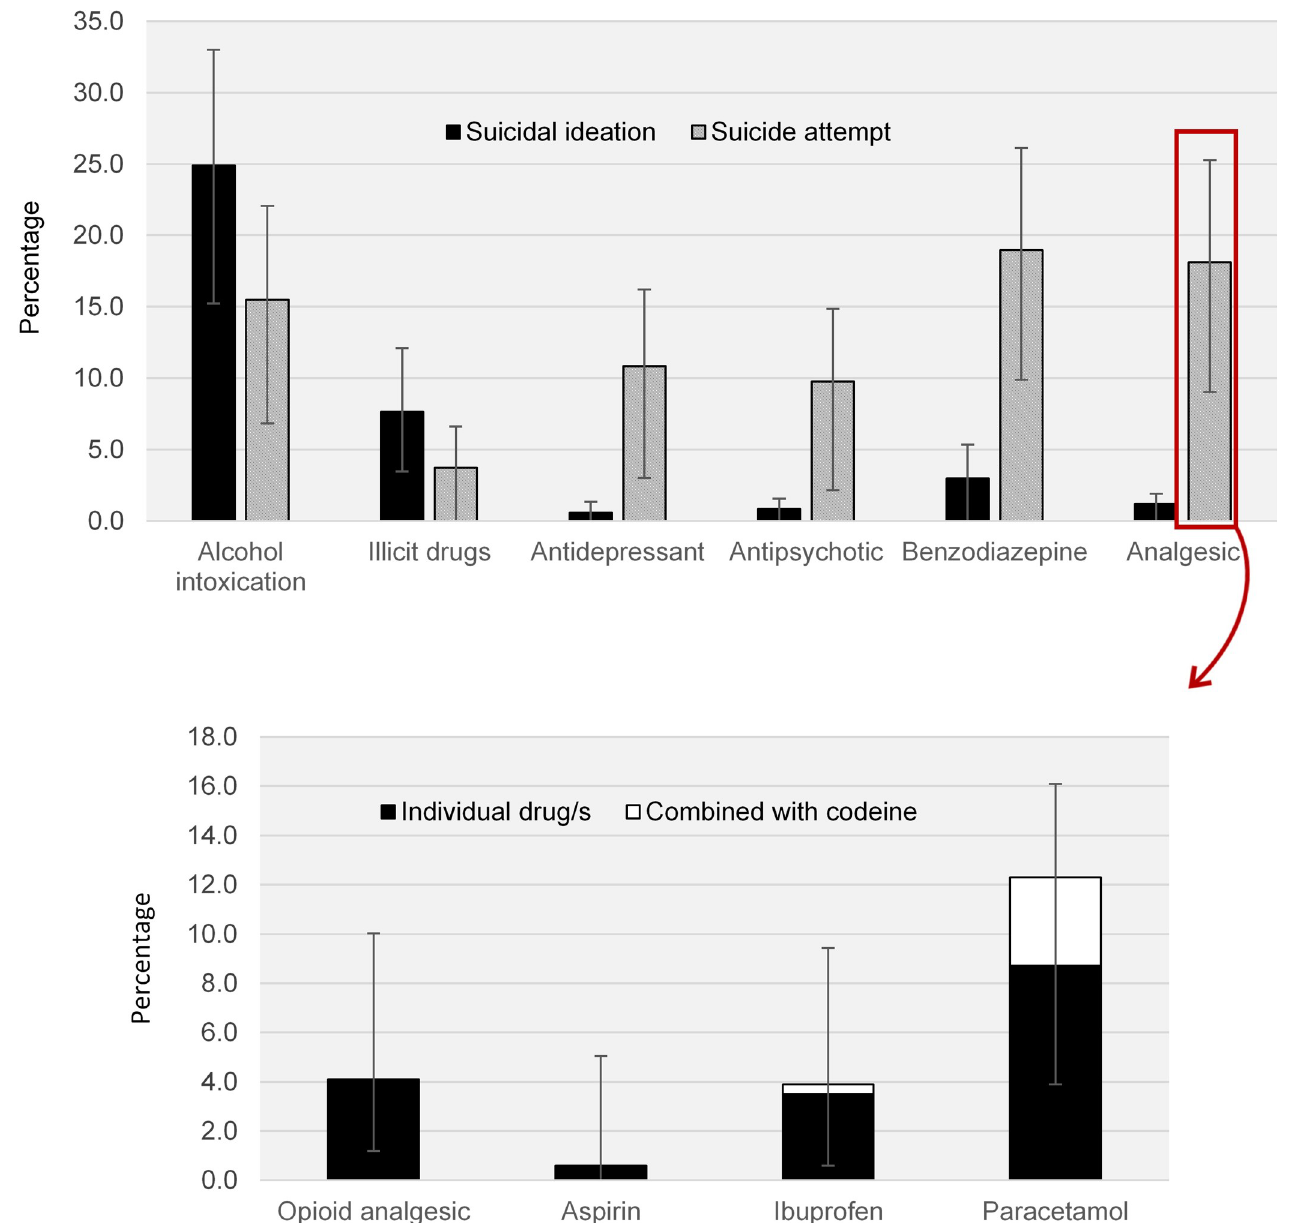
Fig 4. Drugs involved in Victorian suicide ideation and suicide attempt ambulance attendances. (A) Percentage of drug categories involved in Victorian suicidal ideation and suicide attempt-related ambulance attendances, 2012 to 2018. (B) Percentage of individual analgesic drugs involved in Victorian suicide attempt-related ambulance attendances, 2012 to 2018. Error bars represent the binomial proportion confidence interval based on Clopper-Pearson/exact interval.